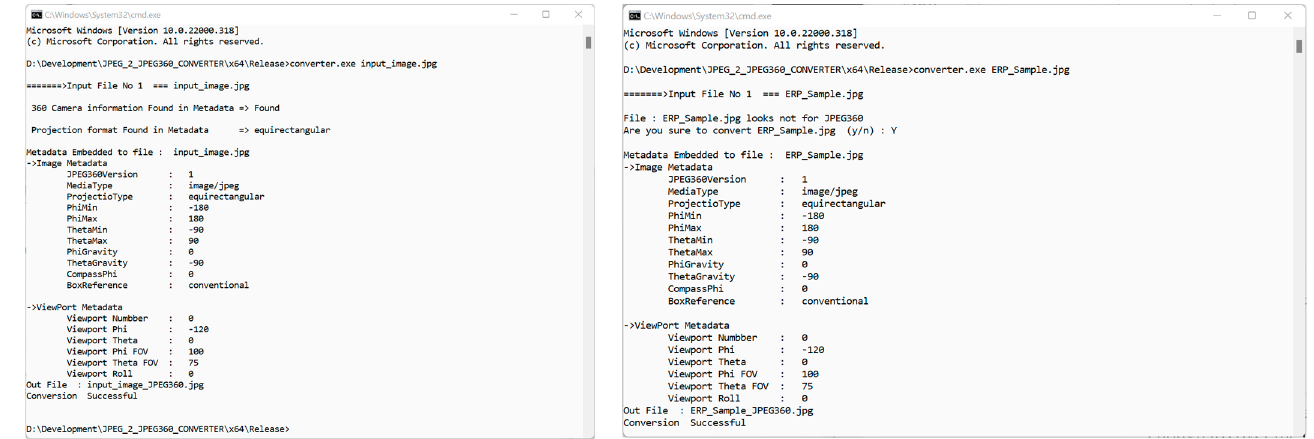
Figure 7. Screenshots of the proposed JPEG 360 converter application.